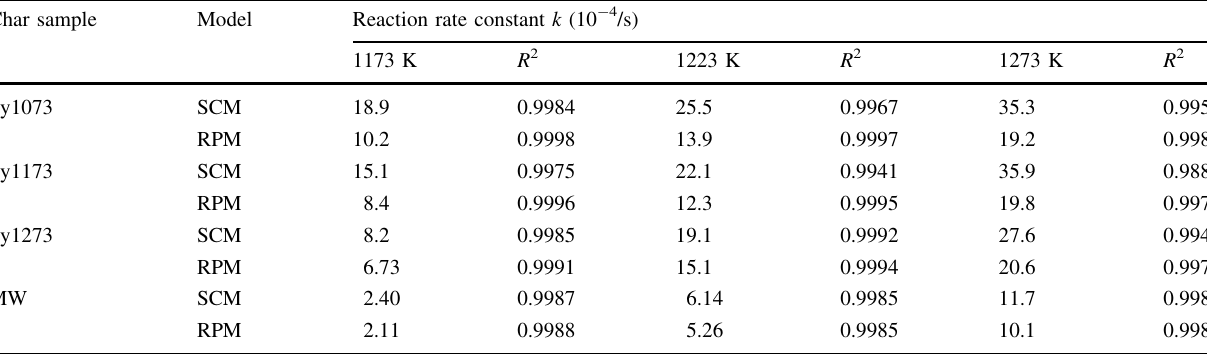
Table 4 k values obtained via linear fits of the experimental data and the coefficients of determination Char sample